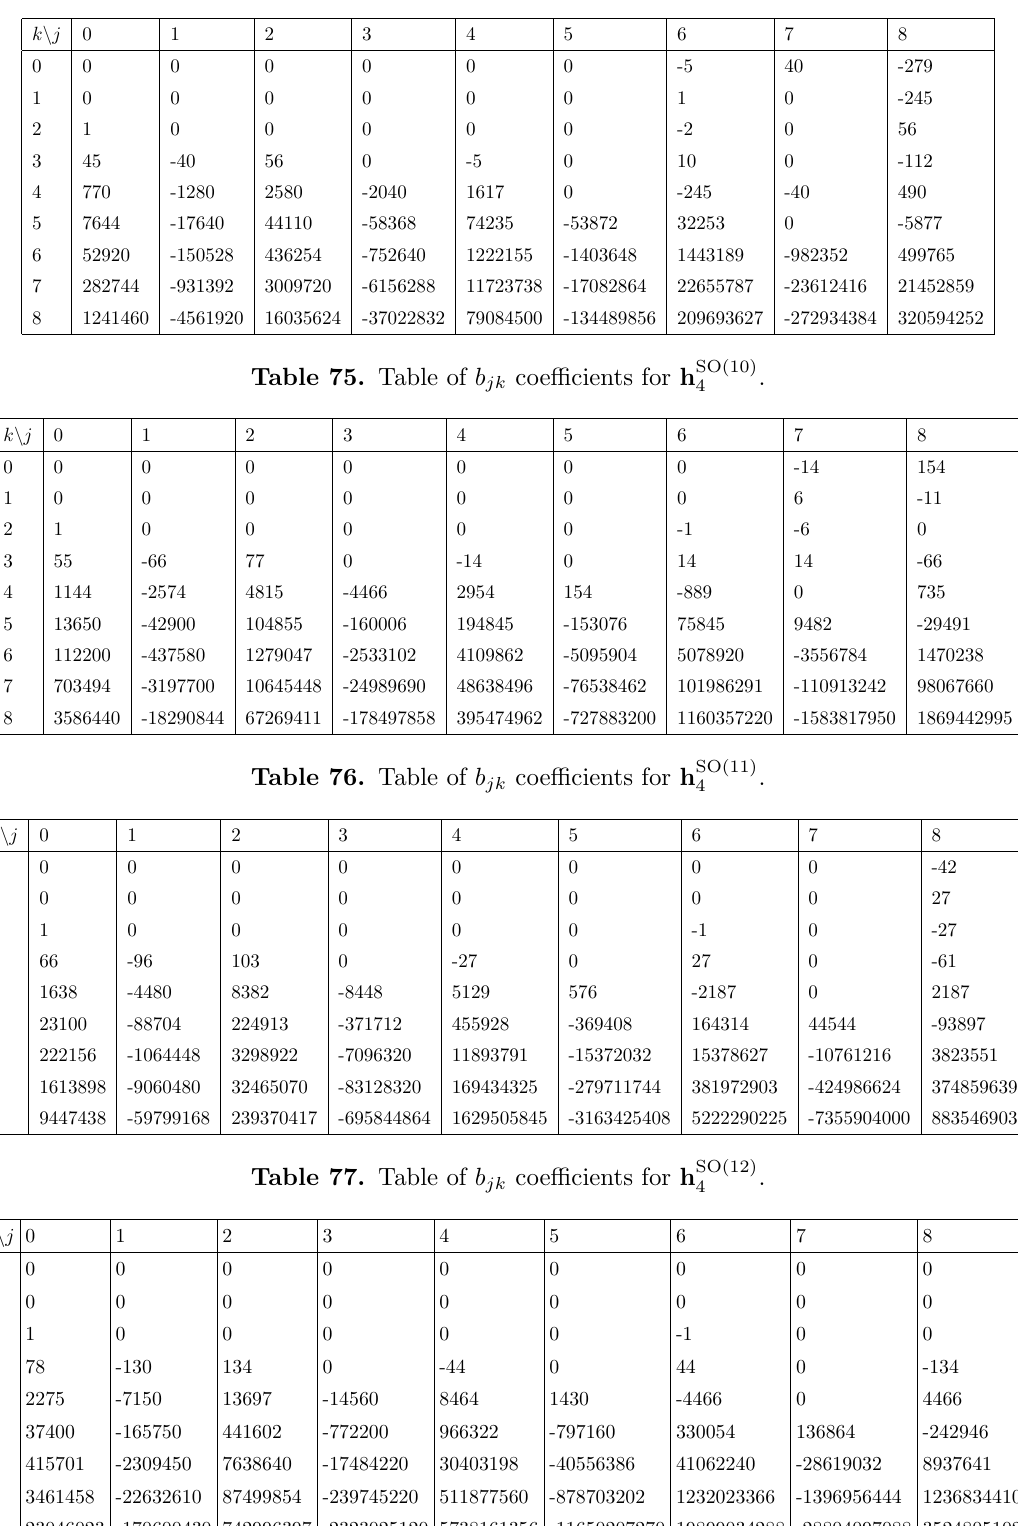
Table 78. Table of b jk coe(cid:14)cients for h SO(13)